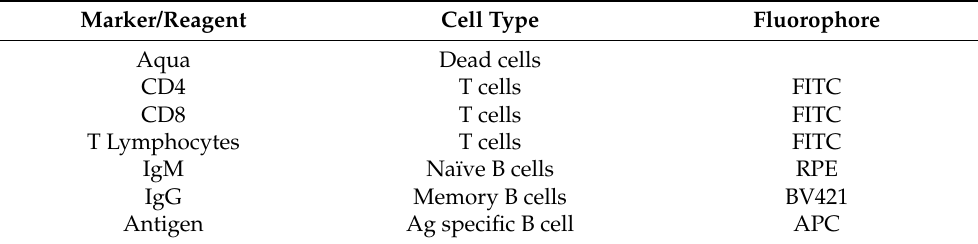
Table 1. Summary of reagents used for isolation of IgG+ antigen specific rabbit B cells.